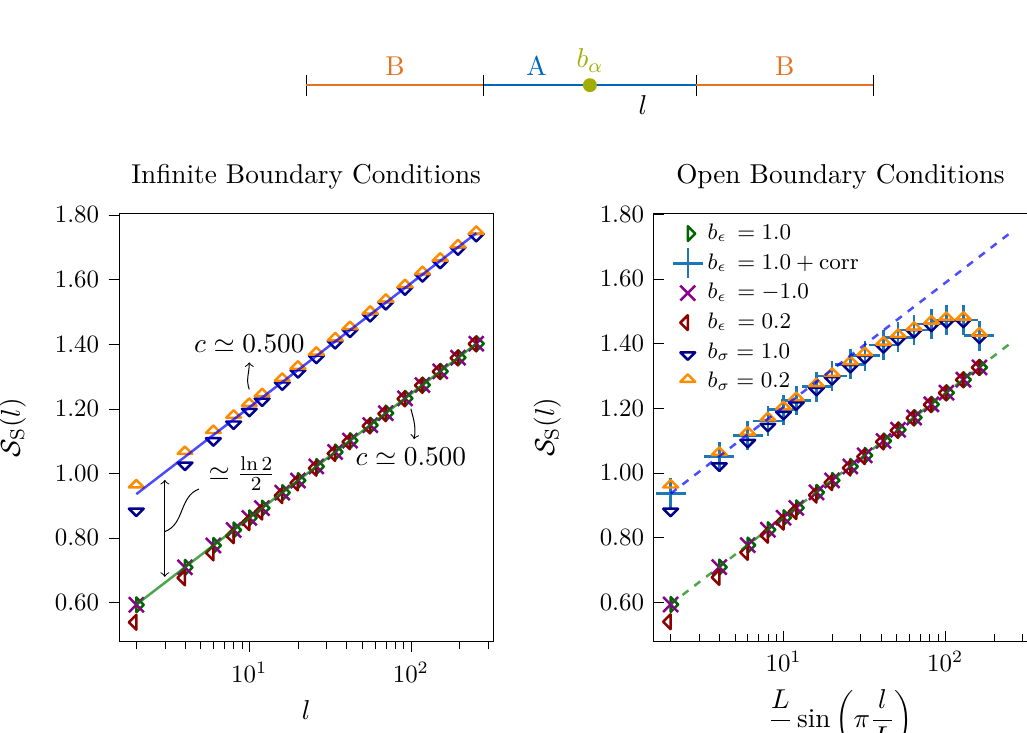
Figure 3 . Scaling of the symmetric EE, S S ( l ) , for a segment A of length l located symmetrically around a defect. We show the results for infinite (left) and open (right) bcs. For finite bc, the total system length is denoted by L . (Left) The symmetric EE scales logarithmically with l for both energy and duality defects for all defect strengths [see eq. (3.2)]. The coefficient of the logarithm for every case gives the expected central charge c = 1 / 2 (the errors in the fits occur in the fourth decimal places). Recall that this coefficient is sensitive to correlations around the entanglement cut, which in this case is located far from the defect (see discussions in section 3.1). The subleading is sensitive to the defect type. For the duality defect of a given strength, this subleading term is (ln 2) / 2 higher than the energy defect of the corresponding strength. This can be viewed as a consequence of the zero-energy mode localized at the defect [see eq. (2.7)]. We note that the symmetric EE does not seem to depend, at least up to O (1) corrections, to the actual defect strength value for a given defect class. (Right) For finite systems, the results are similar to the infinite case for l (cid:28) L with the subsystem size replaced by the chord-length. As l is increased to values comparable to L , deviations occur from usual logarithmic scaling for the duality defect cases due to the existence of the delocalized zero-energy mode [see eq. (2.8)]. The predicted values of the duality defect cases are indicated by the blue crosses, which are obtained by adding ∆ S (1 − l/L ) / 2 to the symmetric EE without any